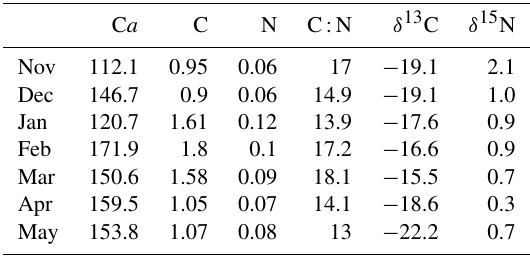
Table 2. Pigment content (Chlorophyll a = gm − 2 ) , total